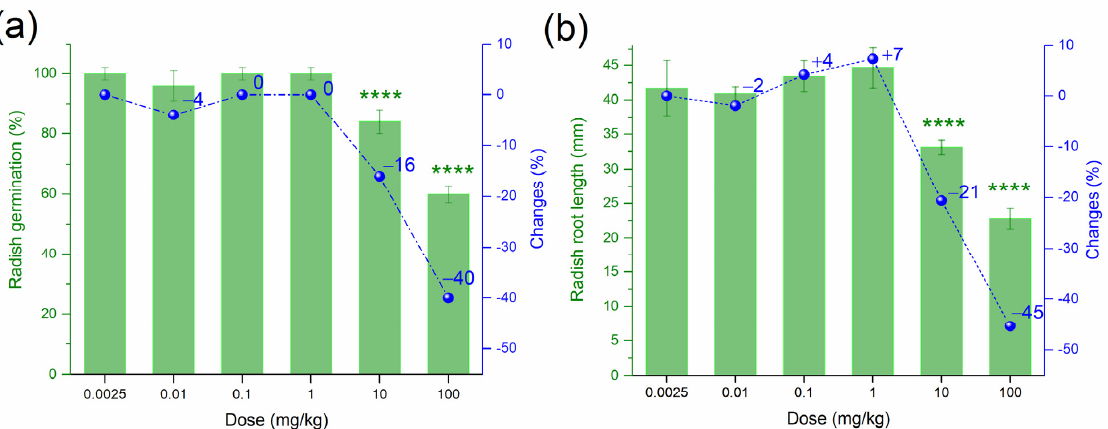
Figure 2. Effect of PtNPs on the phytotoxicity of radish in Haplic Cambisols Eutric ( a ) seed germination and ( b ) length of radish roots with their relative changes compared to the control. (**** p ≤ 0.0001).